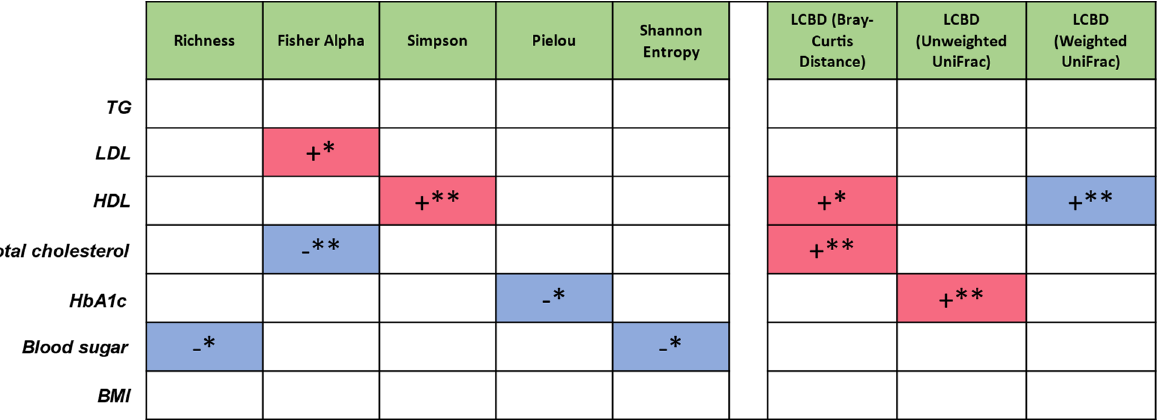
Figure 2. Subset regression where red and blue represent the significant positive and negative beta coefficients that were consistently selected in different regression models. As an example, Blood sugar is having a negative influence on increasing microbial diversity (for 2/5 diversity metrics). Likewise, Total cholesterol is having a positive influence on LCBD ( Bray-Curtis ), shifting the microbial community structure away from the average; *, p < 0.05; **, p < 0.01